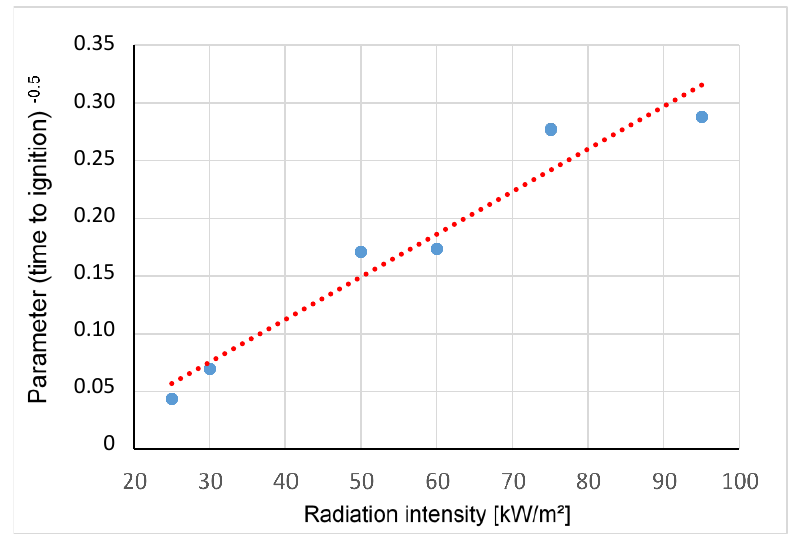
Figure 10. Linear relationship between the different radiation intensities.